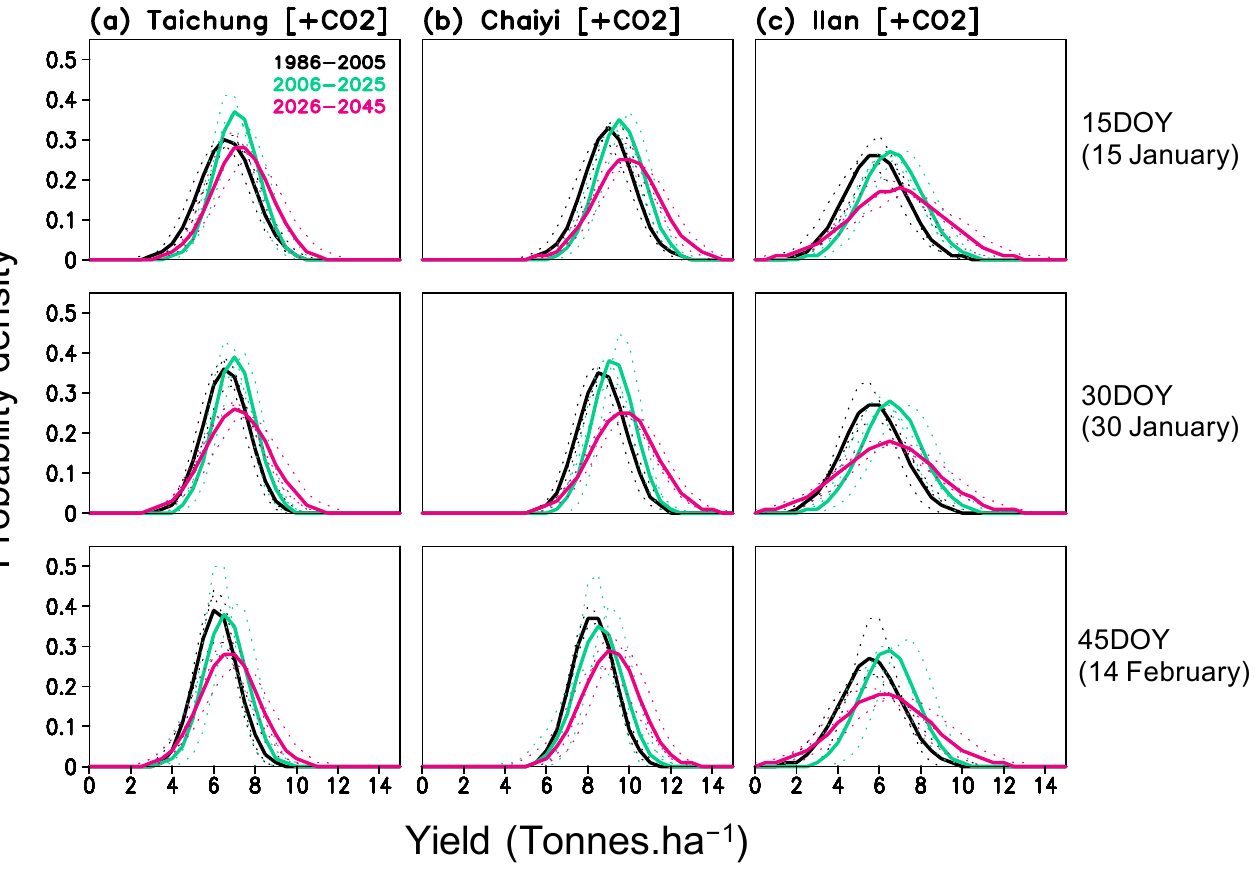
Figure 10. Probability density function of simulated yield (with projected CO 2 ) for three planting dates (15, 30, 45 day of year) and three periods (1986–2005, 2006–2025, 2026–2045) constructed for ( a ) Taichung, ( b ) Chaiyi, and ( c ) Ilan; solid lines are averaged values from 3 models and dotted lines are values of each model.